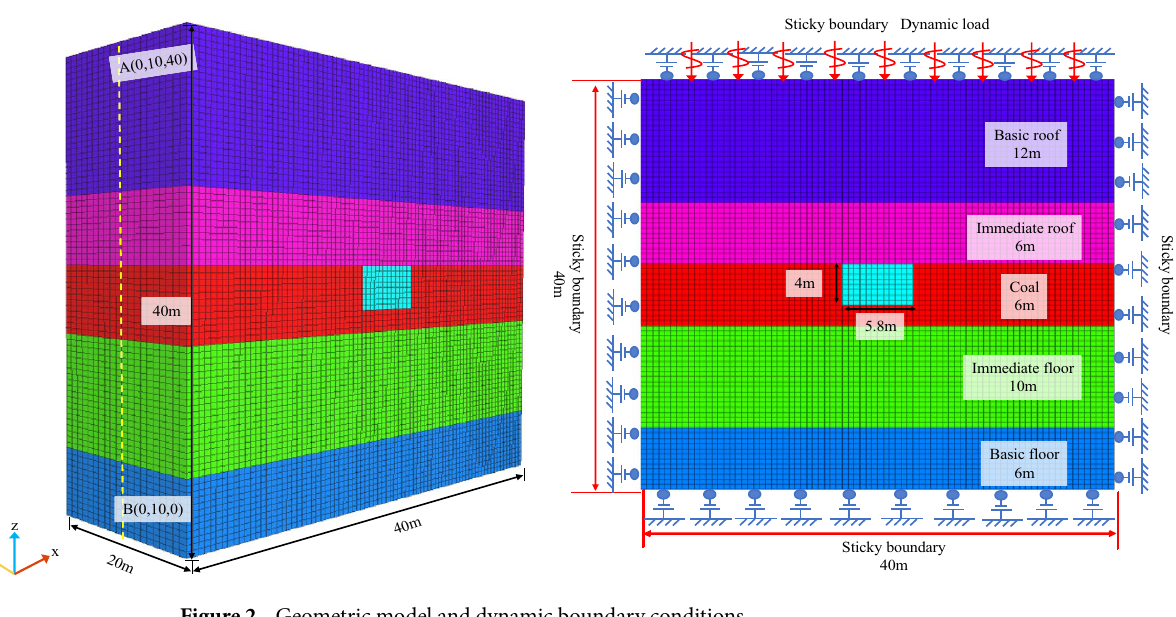
Figure 2. Geometric model and dynamic boundary